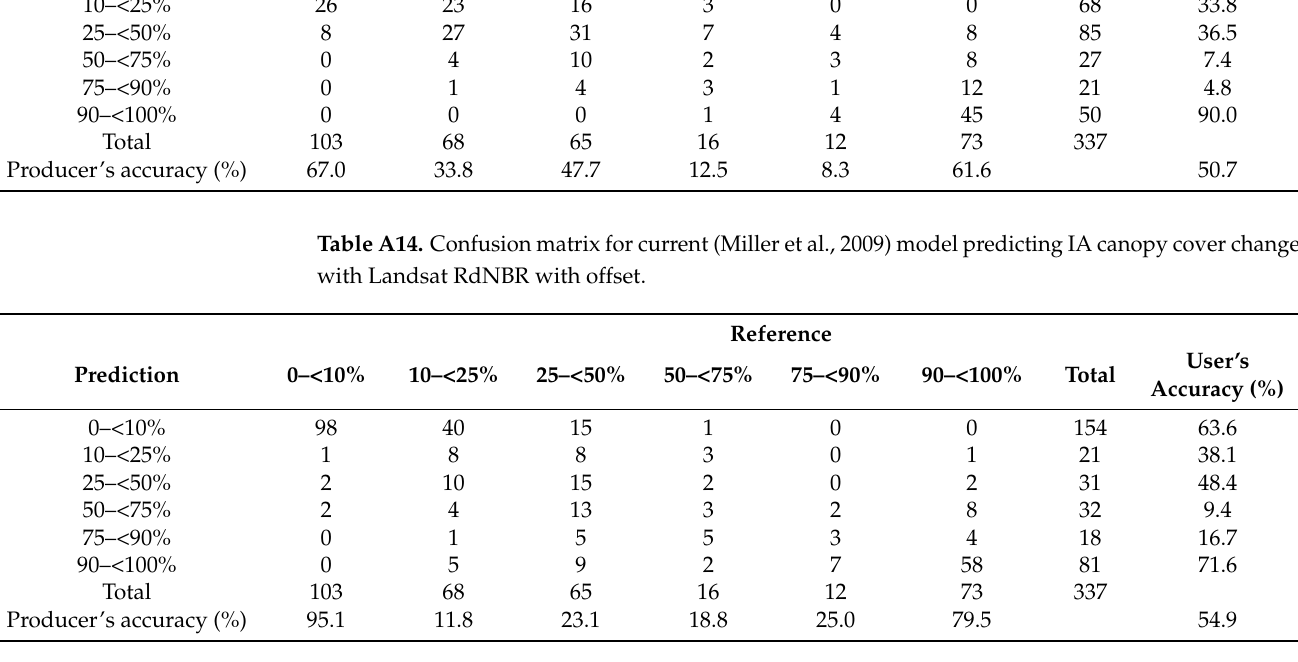
Table A15. Confusion matrix for Southwest model predicting EA CBI with Sentinel-2 RBR with